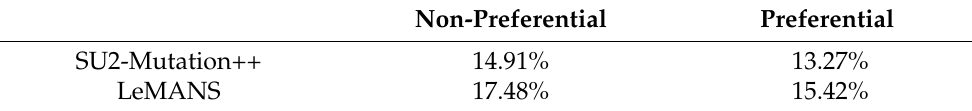
Table 3. Atomic oxygen percentage at 10 − 8 s.